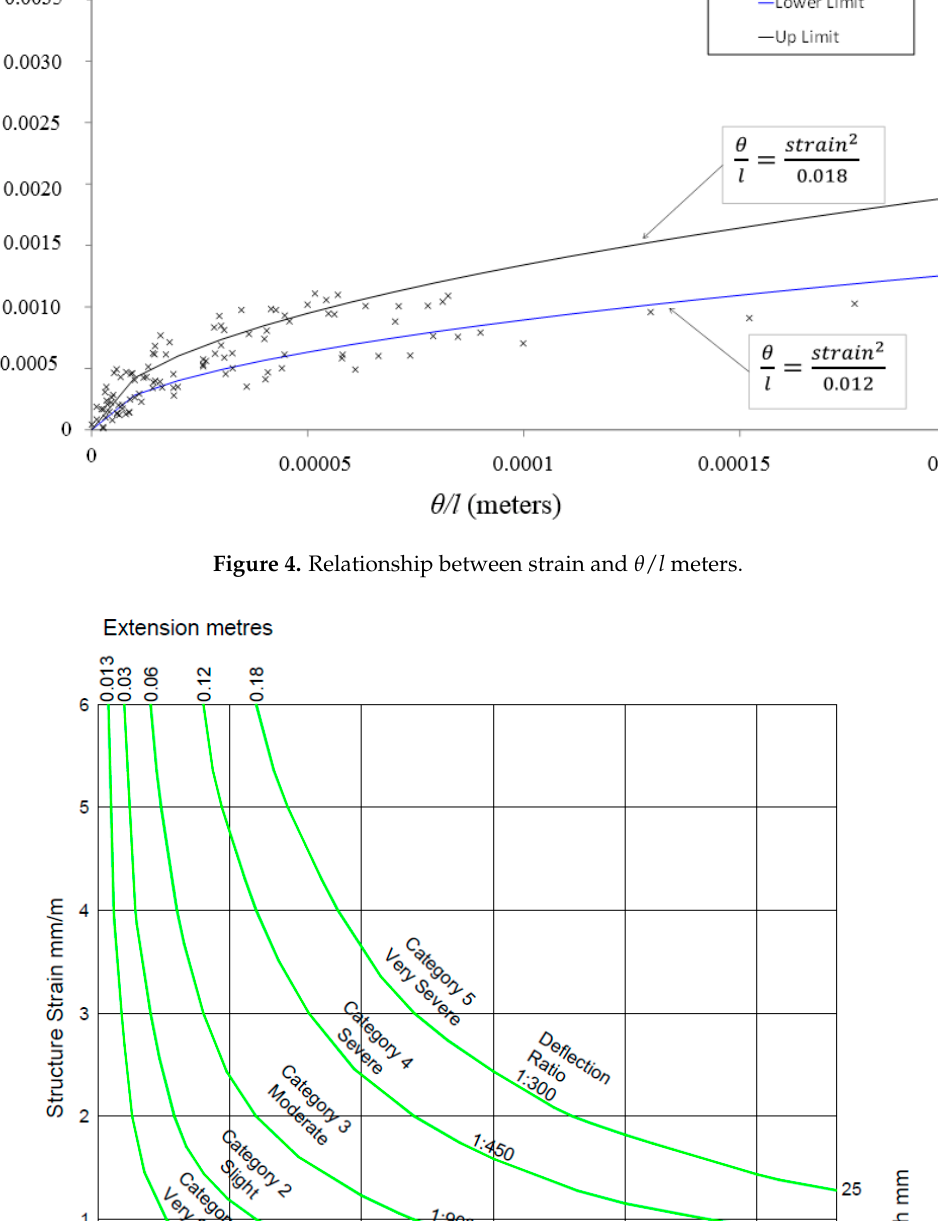
Figure 5. Impact classification with deflection ratios for two-storey brick structures [46].